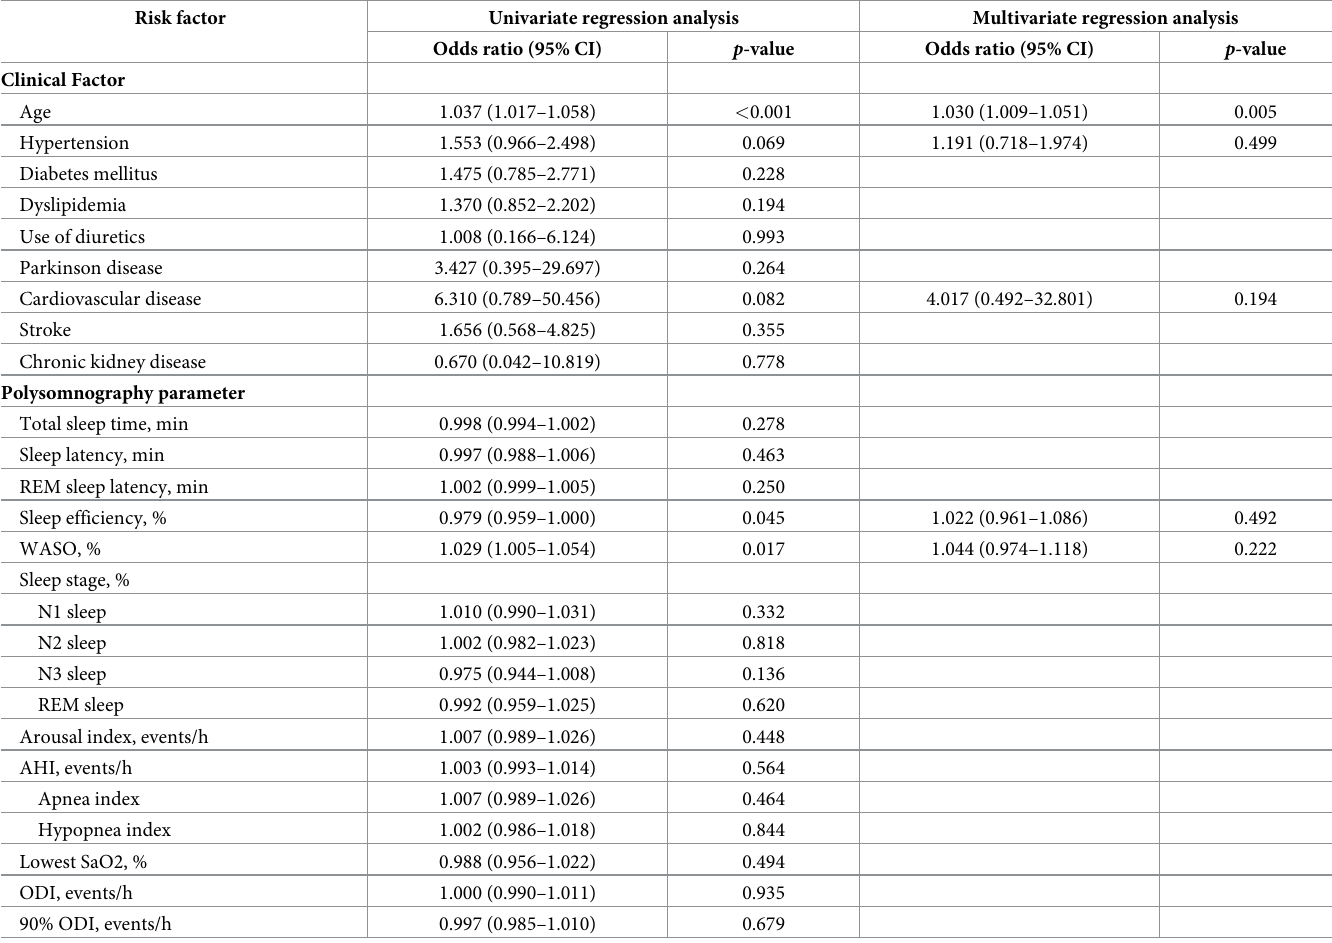
Table 4. Results of logistic regression analysis of factors related to nocturia in female participants with obstructive sleep apnea syndrome (N = 306). Risk